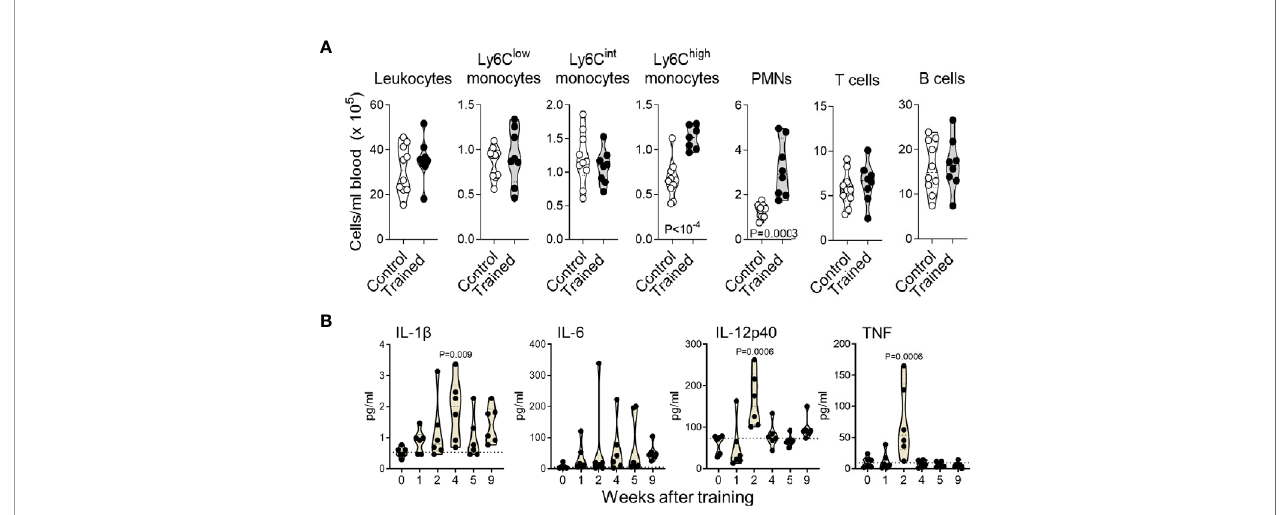
FIGURE 2 | Training for 9 weeks increases blood in fl ammatory monocytes and PMNs. (A) Blood counts of CD45 + leukocytes, Ly6C low , Ly6C lint and Ly6C high monocytes (CD11b + Ly6G - ), PMNs (Ly6G + ), T cells (CD3 + ) and B cells (B220 + ) in control mice ( n = 10) and mice trained for 9 weeks ( n = 8). Data are from 2 independent experiments. (B) Blood concentrations of IL-1 b , IL-6, IL-12p40 and TNF in control mice and mice trained 1-9 weeks before analysis ( n = 6 mice/group). Each dot represents a mouse. Lines represent mean and SD. The dotted horizontal lines in B represent median and limit of detection. P values reaching statistical signi fi cance are given in the